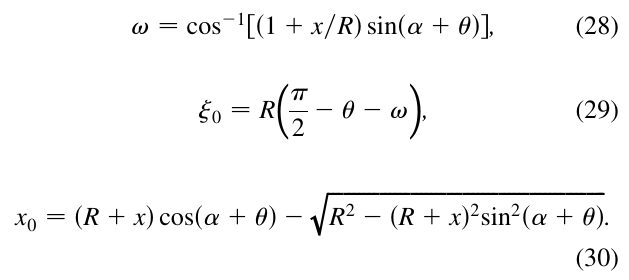
(blue solid curve) with the s